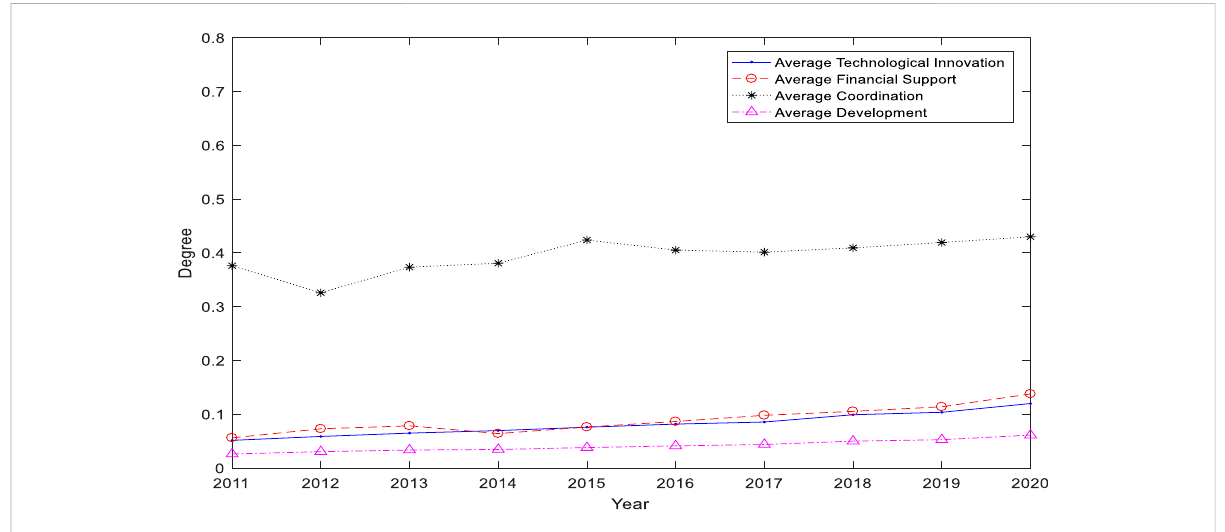
FIGURE 3 Summary on Average Evaluation value of Technology, Finance and Coordination and Development.